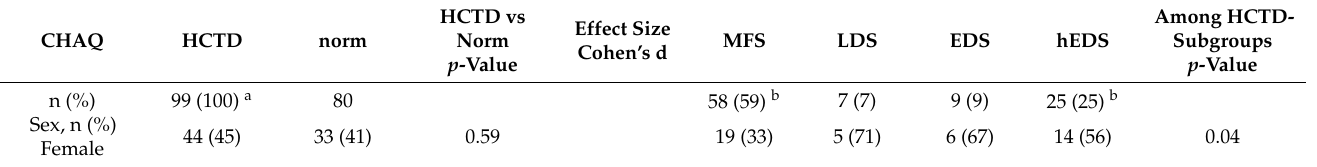
Table 3. Childhood Health Assessment Questionnaire (CHAQ), pain VAS and general health VAS: CHAQ domain scores, CHAQ disability-index scores, pain VAS scores and general health VAS scores; of normative data, the HCTD-group and the HCTD-subgroups: MFS, LDS, EDS and hEDS; comparisons between normative scores and HCTD-group scores; and among HCTD-subgroup